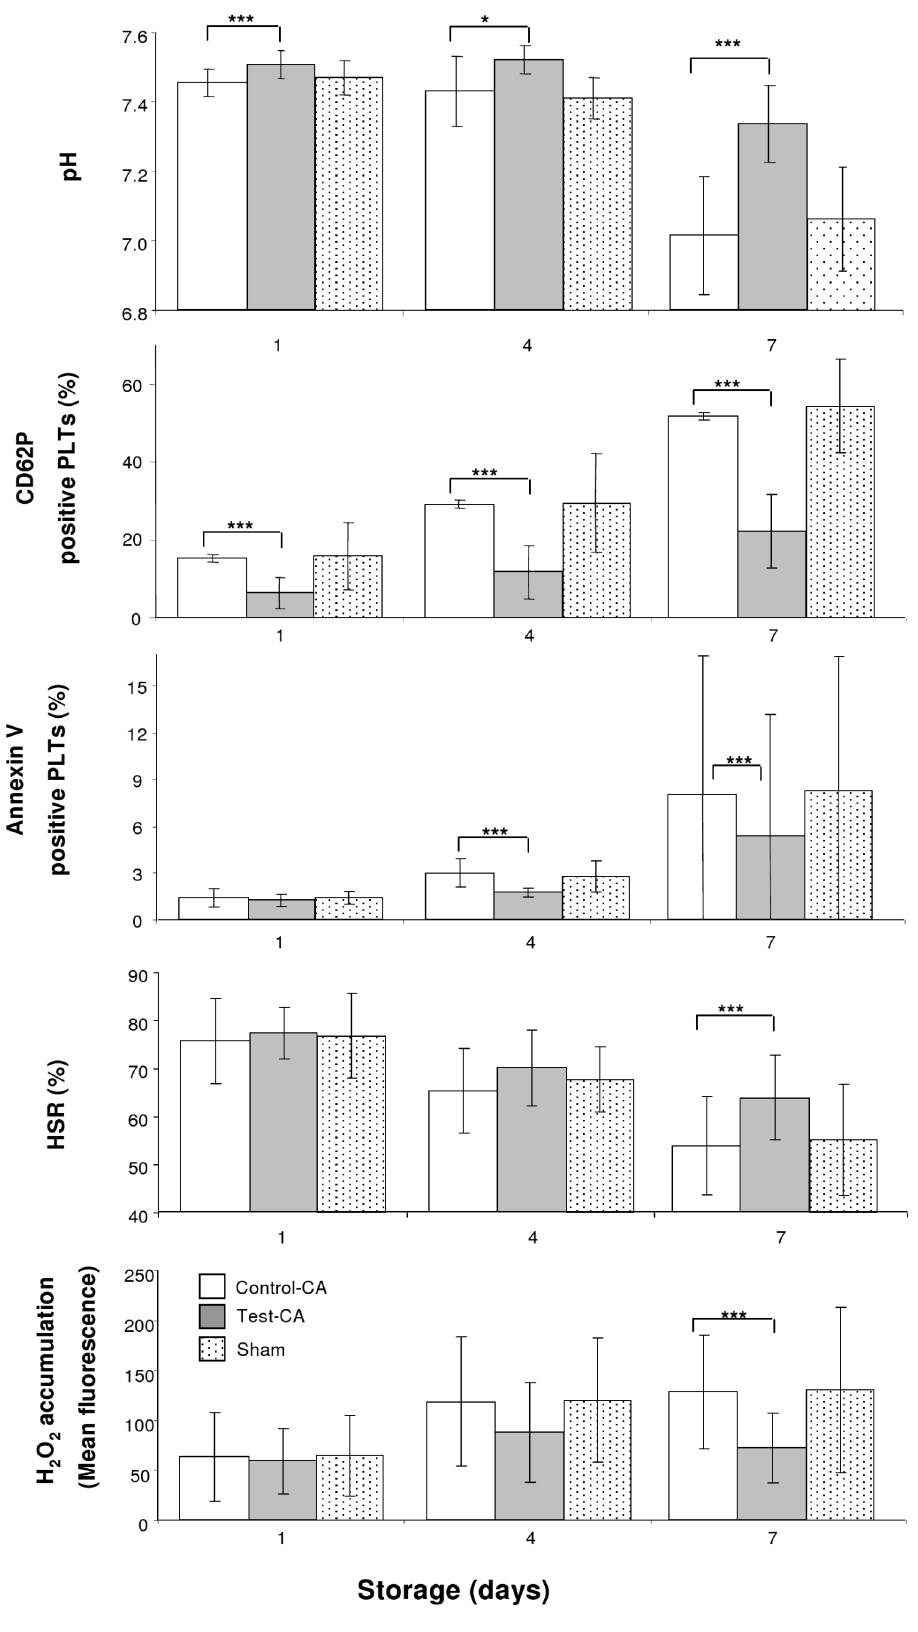
Figure 1. The pH levels, activation, Annexin V binding, HSR, and IHP accumulation of PLTs stored with continuous agitation. * - p , 0.05; *** - p , 0.001. doi:10.1371/journal.pone.0070732.g001 PLOS ONE |